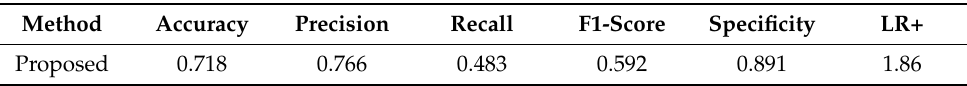
Table 2. TROUT39 dataset recognition performance. Note that the unmatched pairs were randomly generated for